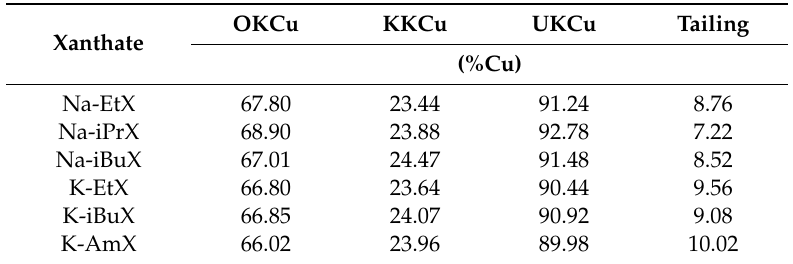
Flotation results obtained using synthesized alkyl xanthate and real ore sample (Elacite–Bulgaria) at the laboratory level (copper content of ore—1.8515%, OKCu—basic flotation (first flotation step), KKCu—extended flotation (second flotation step), UKCu—total floated copper, tailing—residual content of copper).